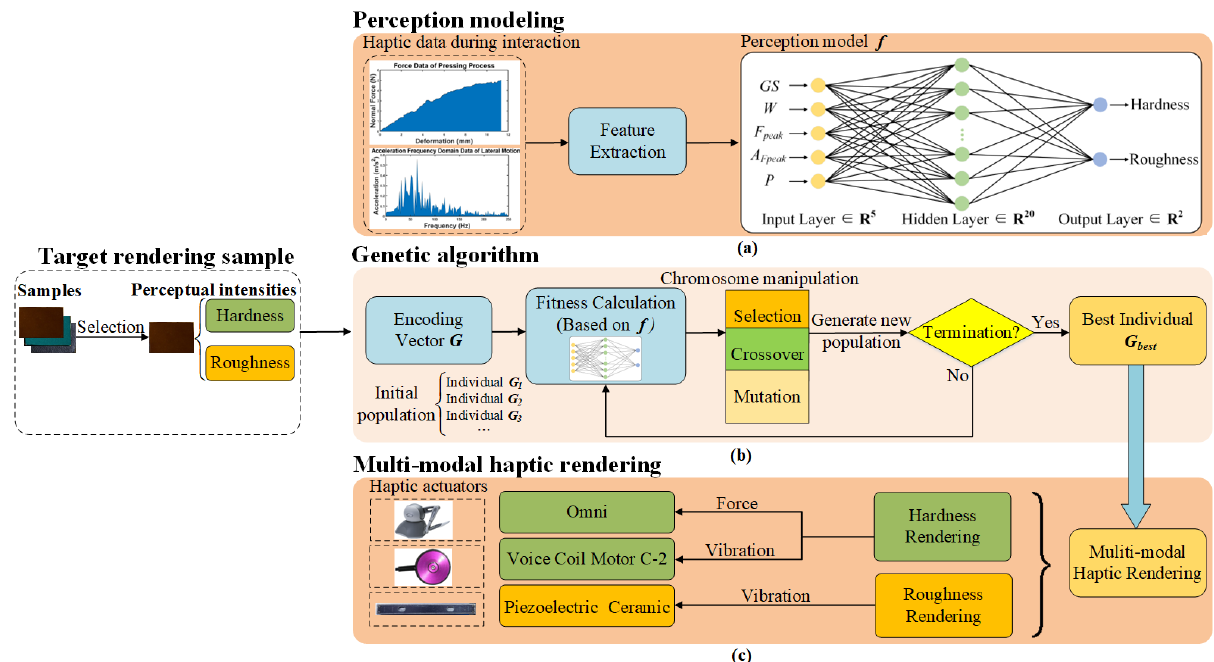
Figure 1. ( a ) Perception modeling. BP neural network is used to implement the perception model that establishes the mapping from objective features to perception intensities. ( b ) Select the target rendering sample. GA generates populations and utilizes the perception model to calculate the fitness of the individual. The best individual G best is not obtained until termination. ( c ) G best is used to control different haptic actuators for multi-modal haptic